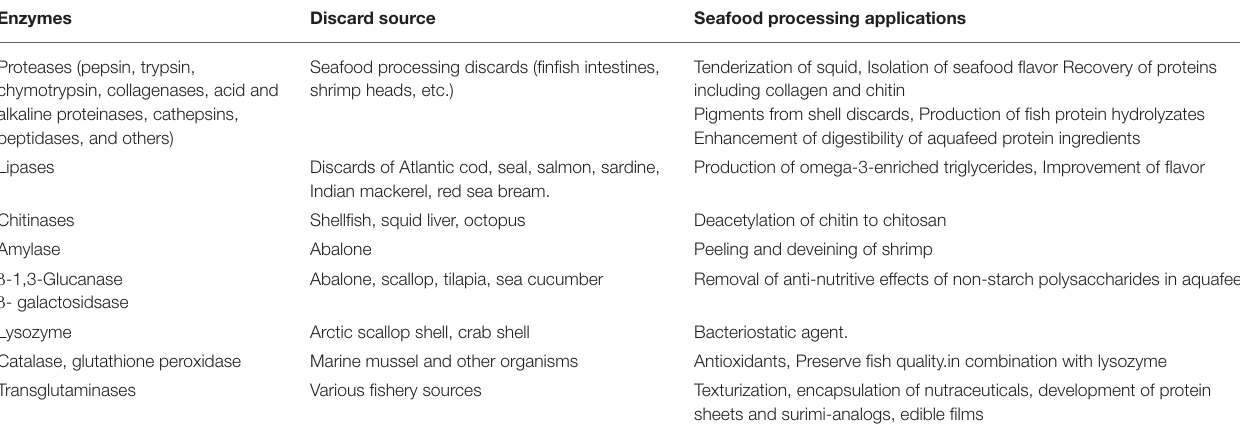
TABLE 3 | Enzymes from seafood processing discards for seafood processing. Enzymes Discard source Seafood processing